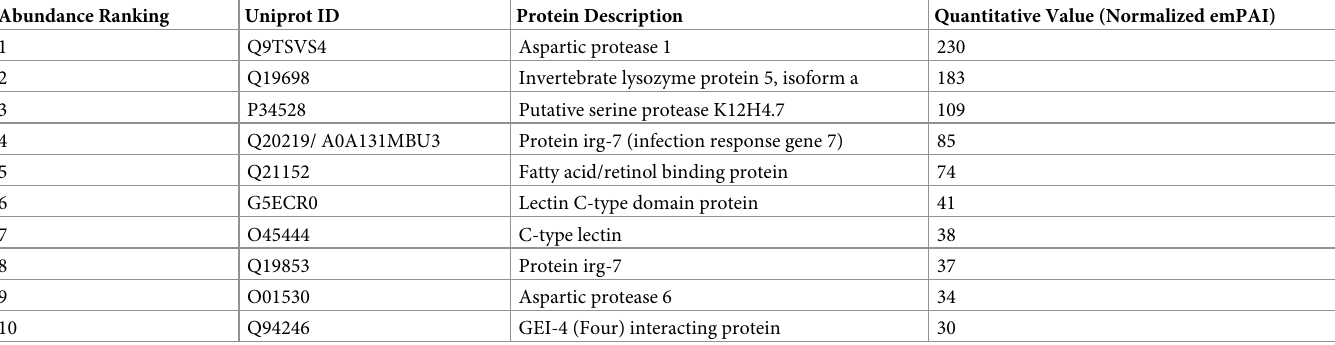
Table 2. Top 10 proteins identified in the C . elegans secretome. Proteins were ranked by relative abundance using the emPAI values in Scaffold. Abundance